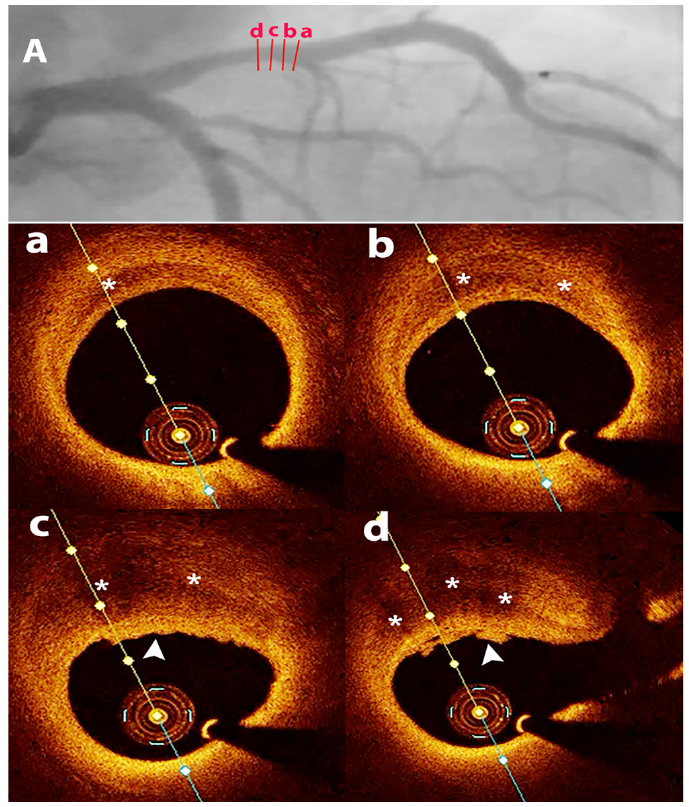
Figure 4. SCAD in a 48 years old female patient with non ST segment elevation myocardial infarc- tion. ( A )—coronary angiography—borderline proximal left anterior descending artery stenosis; ( a – d )—OCT—transversal views—SCAD—in wall hematoma (asterisks) with thrombus on the inti- mal surface (white arrowhead in c and d), with significant lumen reduction, followed by PCI.